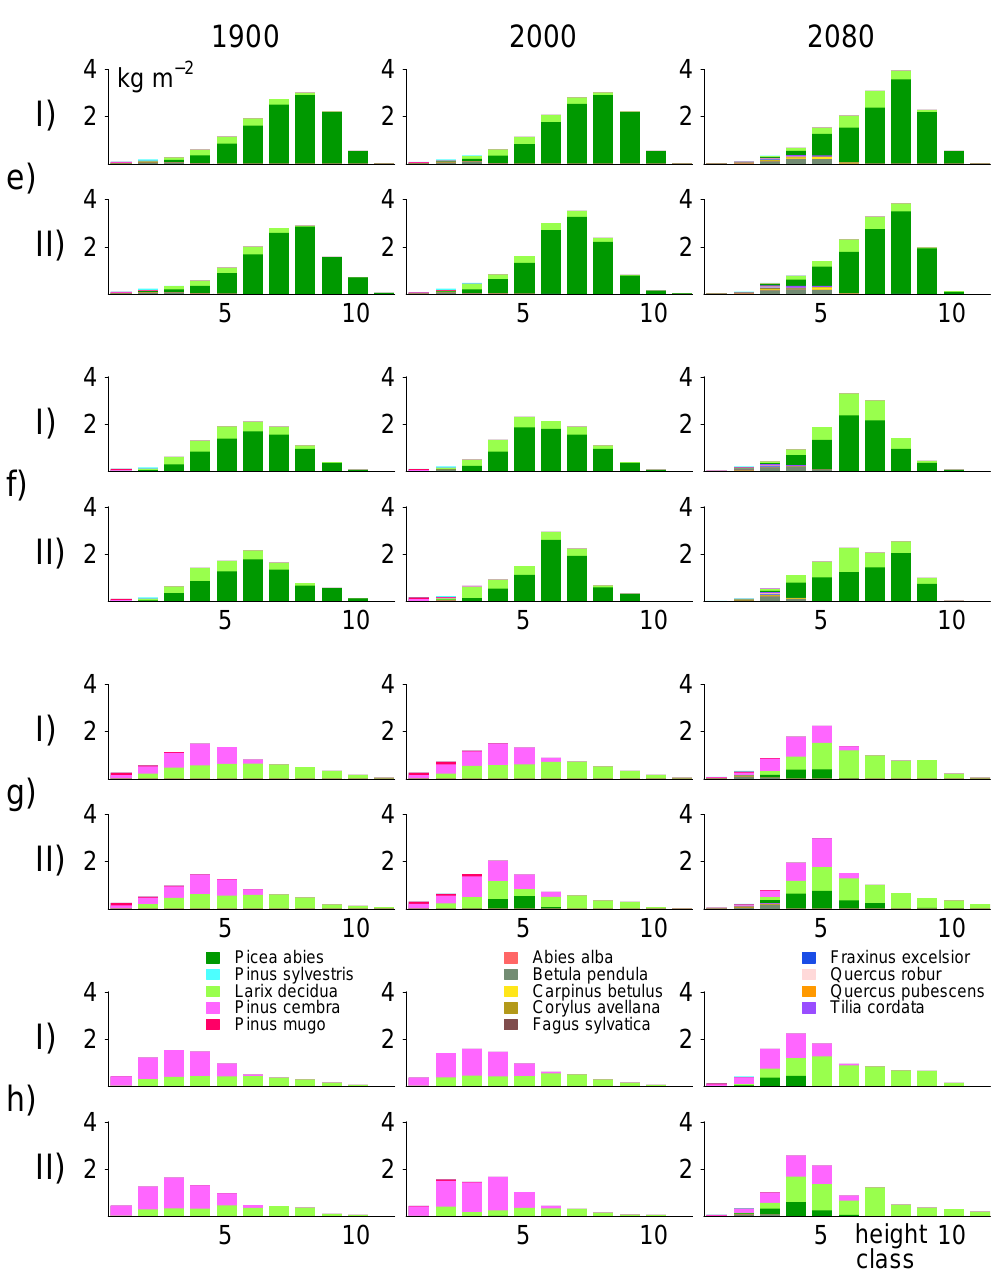
Fig. D5. Simulation results for stands (e) – (h) for the simulation years 1900, 2000 and